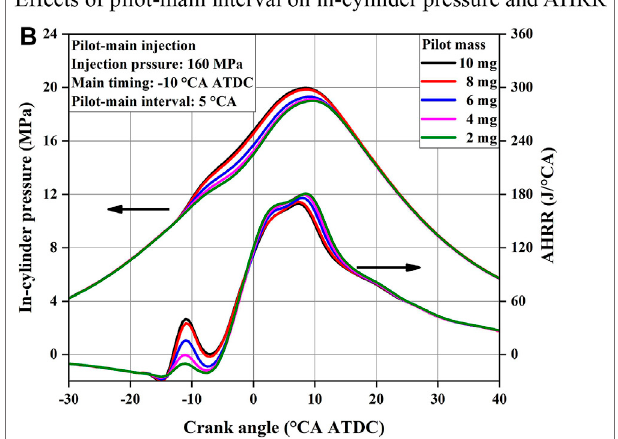
FIGURE 5 | Effects of pilot-main interval and pilot mass on combustion characteristics. (A) Effects of pilot-main interval on in-cylinder pressure and AHRR. (B) Effects of pilot mass on in-cylinder pressure and AHRR.